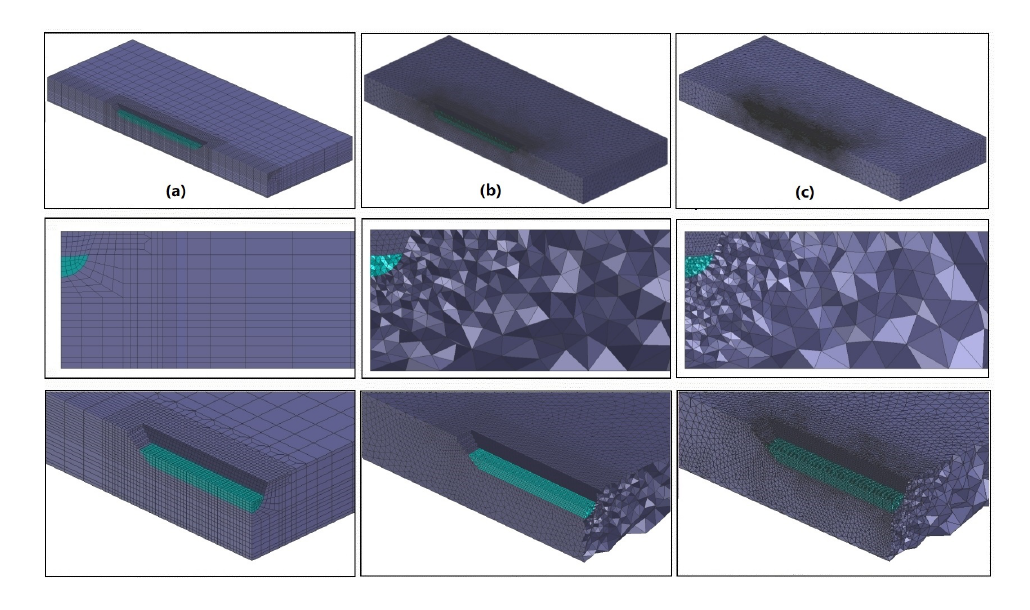
Figure 5. Meshes— ( a ) hexaheral mesh (27,000 3D elements/29,000 nodes), ( b ) free tetrahedral mesh (129,277 3D elements/24,865 nodes), ( c ) free tetrahedral mesh (163,798 3D elements/34,588 nodes); Top: global-meshes—Middle: 2D sections—Bottom: zooms on the weld